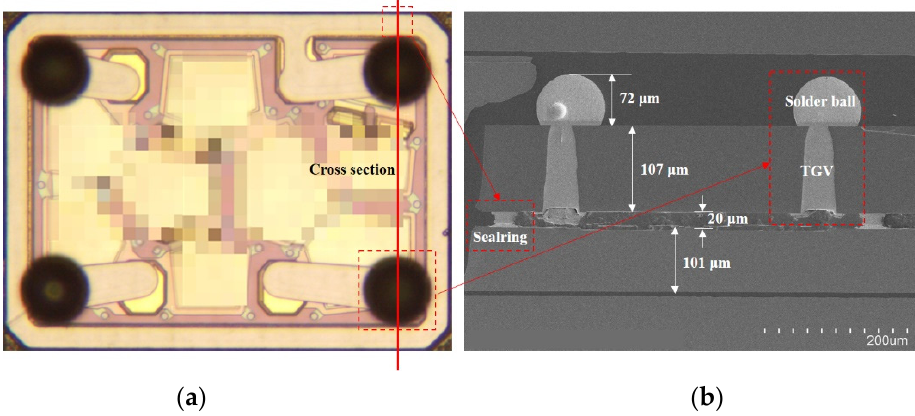
Figure 12. The RF filter package with TGVs after solder ball formation. ( a ) The OM picture of the RF filter package. ( b ) The cross-section view of the RF filter WLP with the solder ball.